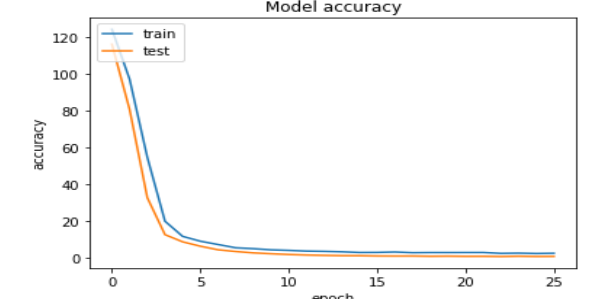
Figure 5 Line plot of Mean Squared Error showing the loss error over the training